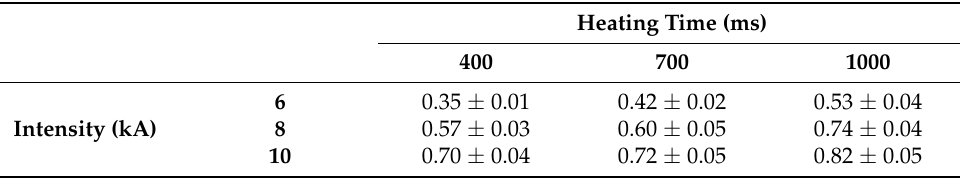
Table 2. Specific thermal energy ( STE ) values (expressed in kJ/g) for the different MF-ERS experi- ments. The mean values and standard deviations were computed from the values measured in four compacts obtained under identical